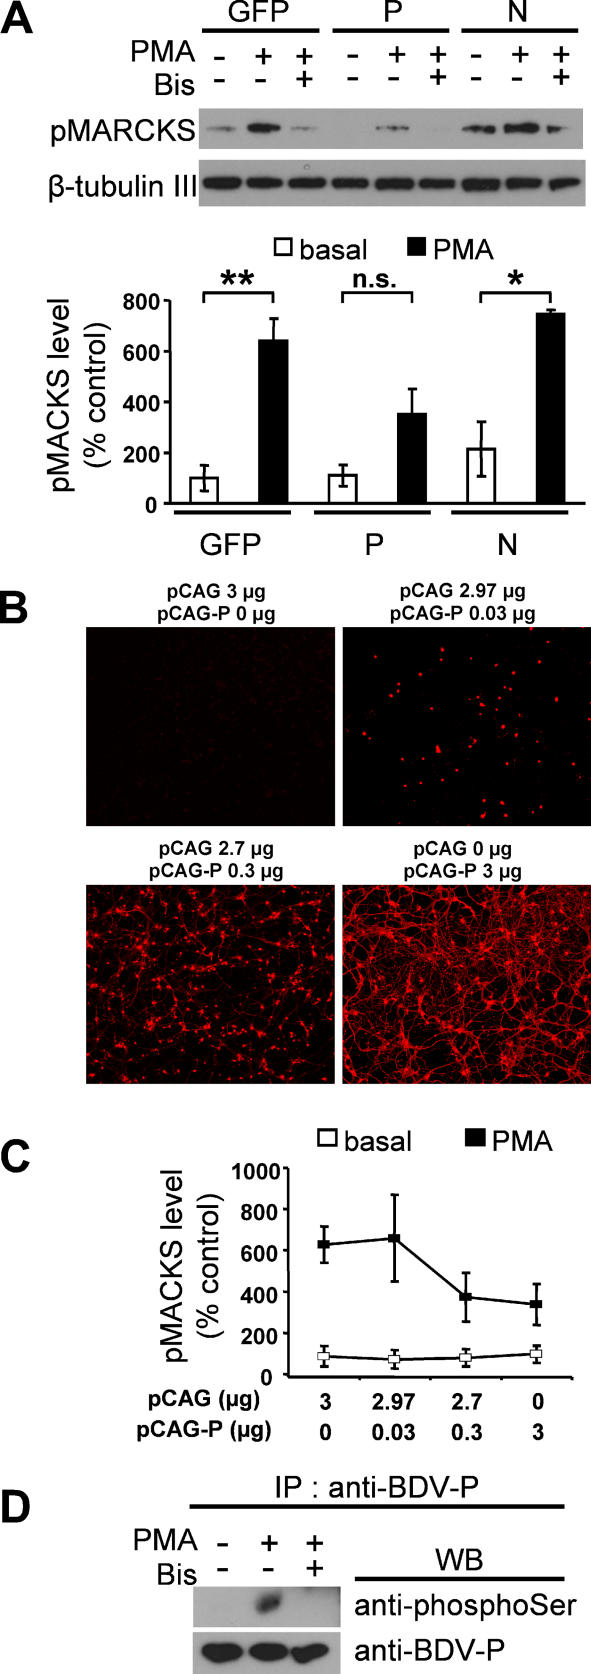
BDV P Interferes with PKC-Dependent Phosphorylation(A) Phosphorylation of MARCKS following treatment with PMA was analyzed in neurons transfected with expression vectors for GFP, BDV P, and BDV N. β-Tubulin III is used to normalize expression. Results are expressed as percentage of non-stimulated GFP-transfected neurons.(B) Immunofluorescence analysis of BDV P expression in neurons transfected with increasing quantities of the BDV P plasmid (pCAG-P). When necessary, the amount of pCAG-P plasmid was supplemented with empty plasmid (i.e., the same pCAG plasmid backbone without insertion of P), so that the total amount is 3 μg in all cases Note that BDV P is detected in neuronal processes, starting at 0.3 μg pCAG-P used in the transfection.(C) Dose-dependent interference of BDV P with PKC signaling. Phosphorylation of MARCKS following treatment with PMA was analyzed in neurons transfected with increasing quantities of BDV P plasmid (pCAG-P). The results are representative of four to seven independent experiments. Results are expressed as percentage of unstimulated neurons transfected with the empty vector.(D) BDV P is phosphorylated by PKC following treatment with PMA. BDV P was immunoprecipitated from BDV-infected neurons and subjected to Western blot analysis with a phospho-serine antibody. The membrane was then stripped and subjected to staining for BDV P. The phospho-serine positive band co-localizes with the band corresponding to P and is no longer detected in neurons preincubated with PKC inhibitor Bis. Single asterisk (*) indicates p < 0.05; double asterisks (**) indicate p < 0.01 by unpaired t test.